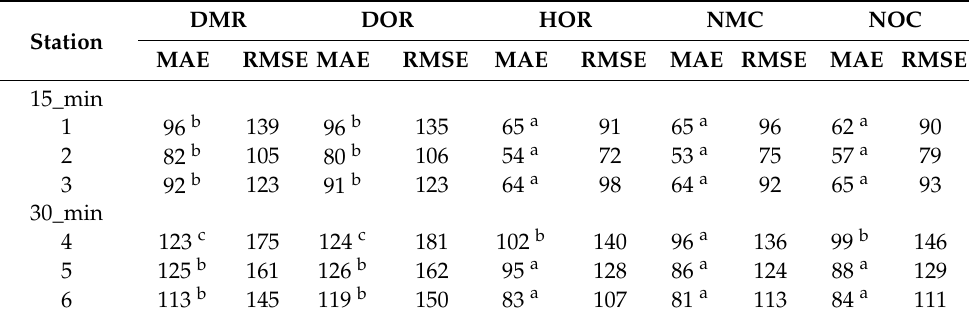
Table 2. Daily mean absolute error and root mean squared error in minutes, according to regions and